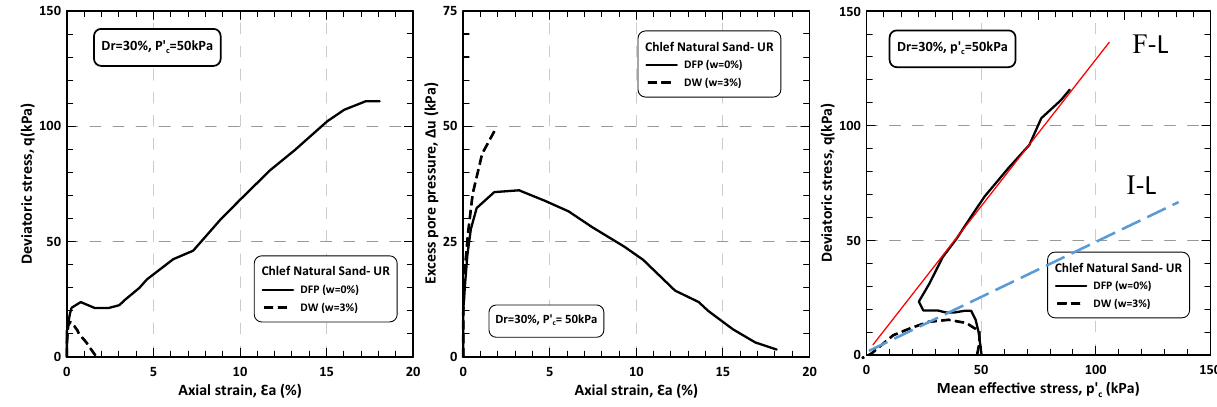
Fig. 5 Effect of deposition method on the undrained response of unreinforced sand samples at p ′ stress versus axial strain, b excess pore pressure against axial strain, c effective stress path